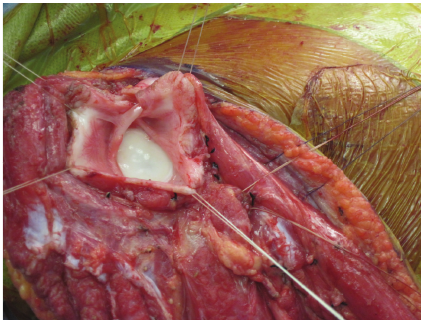
Figure 6: Preserved rotator cuff and shoulder joint capsule marked with tag sutures.